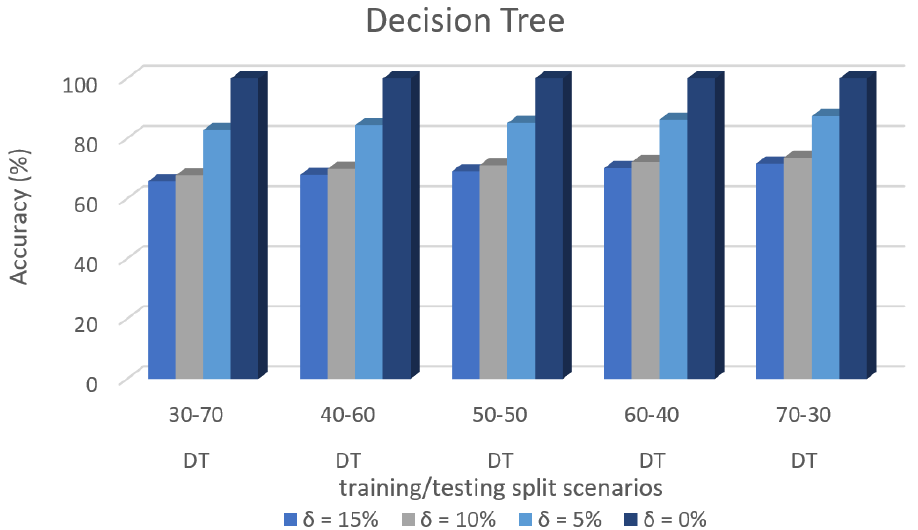
Figure 19. Accuracy Prediction for Dataset 3 using Decision Tree Algorithm.